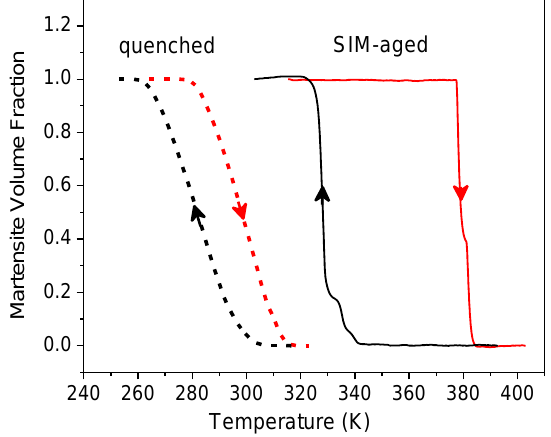
Figure 3. Hysteresis loops calculated from the DSC curves for the quenched and SIM-aged Ni 51 Fe 18 Ga 27 Co 4 single crystals (10 K /